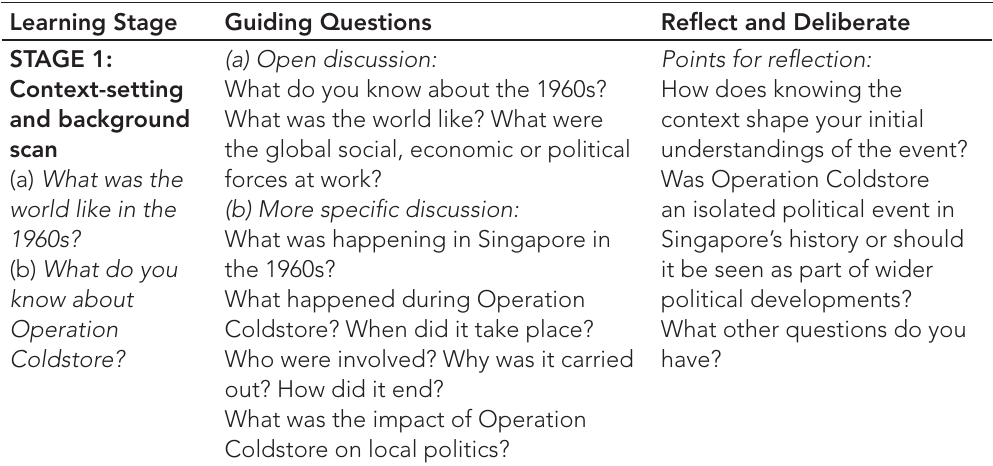
Table 1: Summary of learning stages, guiding questions and points for reflection Learning